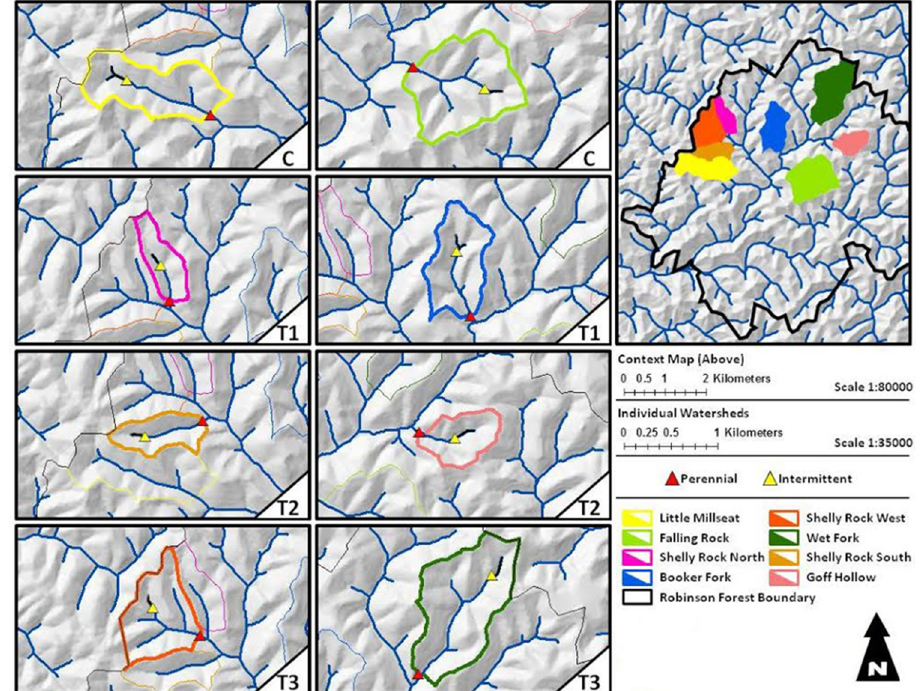
Figure 1. Robinson Forest is an approximately 6000 ha experimental forest located in portions of Breathitt, Perry and Knott counties, Kentucky. This study was conducted on the main block (outlined in black) in the 1538 ha Clemons Fork watershed. Falling Rock and Little Millseat branches represent the unharvested control (C) watersheds. Shelly Rock North and Booker Fork are treatment 1 (T1) watersheds. Shelly Rock South and Goff Hollow are treatment 2 (T2) watersheds. Shelly Rock West and Wet Fork represent treatment 3 (T3) watersheds. Perennial (blue line) and intermittent (black line) stream segments were created in ArcMap using a 10 m Digital Elevation Model and the Hydrology tools in Spatial Analyst. Adapted from Witt 2012 [30].